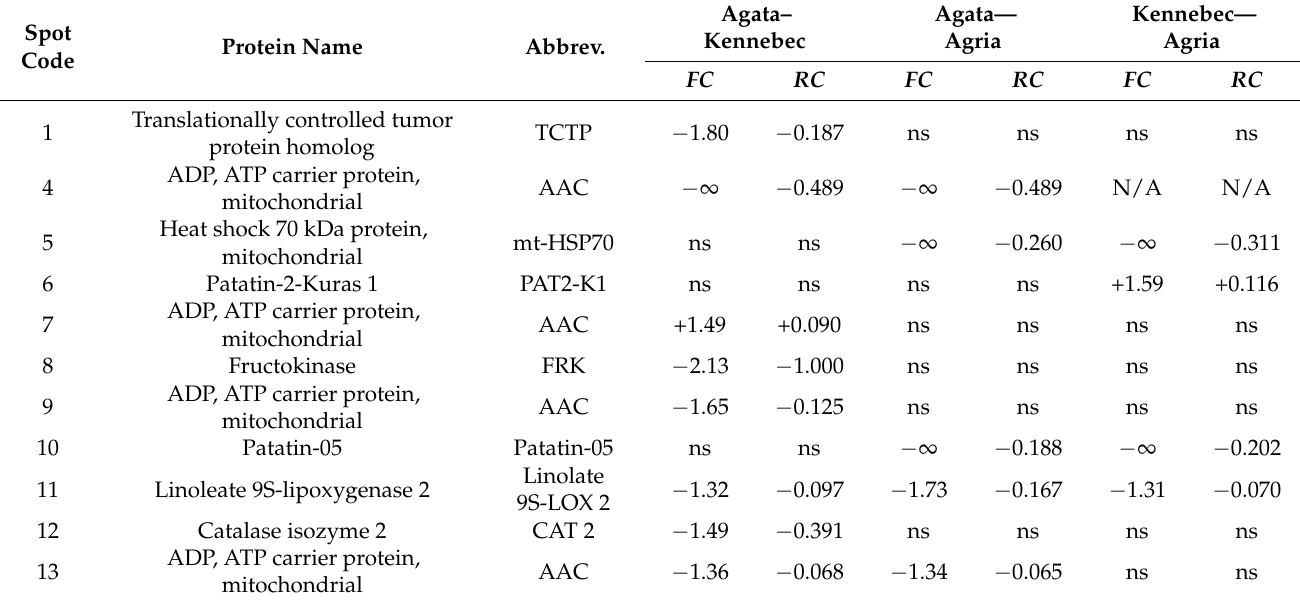
Table 3. Fold change ( FC ) and relative change ( RC ) of differentially abundant proteins ( p value < 0.05) between pairwise potato